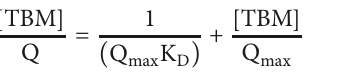
Figure 2: Process for preparing of